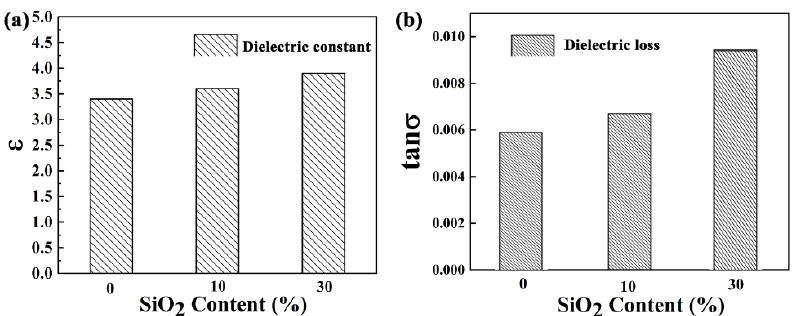
Figure 7. Dielectric constant ( a ) and dielectric loss ( b ) of various coatings.